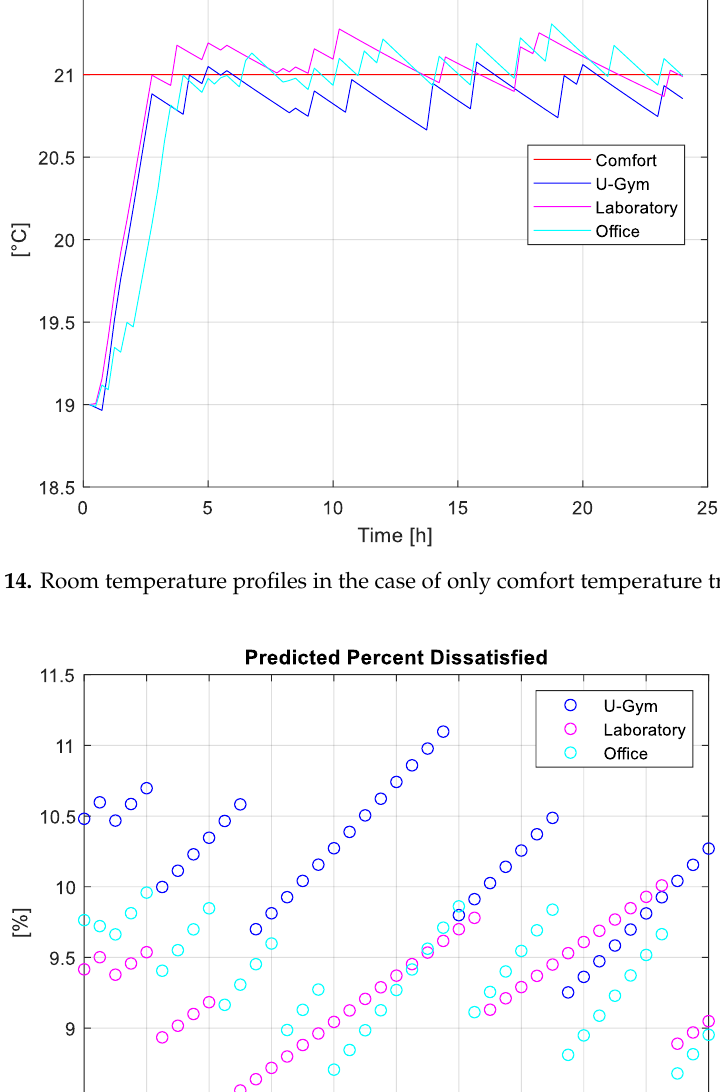
Table 2. Discomfort indicator values.